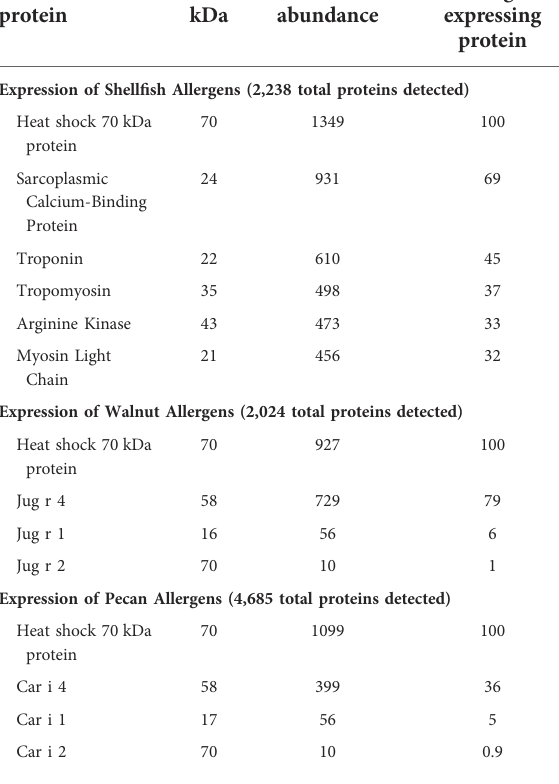
TABLE 1 Expression of shell fi sh, walnut, and pecan allergens from DNA plasmids as determined by mass spectrometry. Identi fi